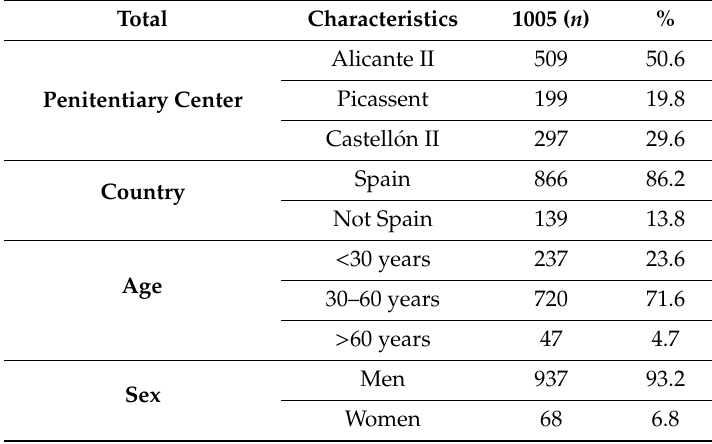
Table 1. Distribution of the sample according to study variables.